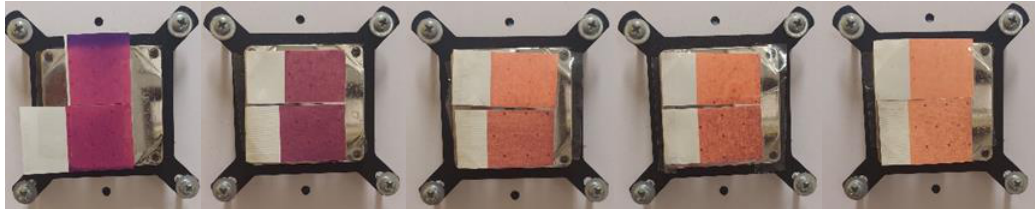
Figure 12. Visual presentation of thermochromic print of heat activated TC ink PP-31 at 20 °C, before and after exposure of samples to UV radiation (6, 12, 18, and 24 h) (above CHR sample, below NMF sample).